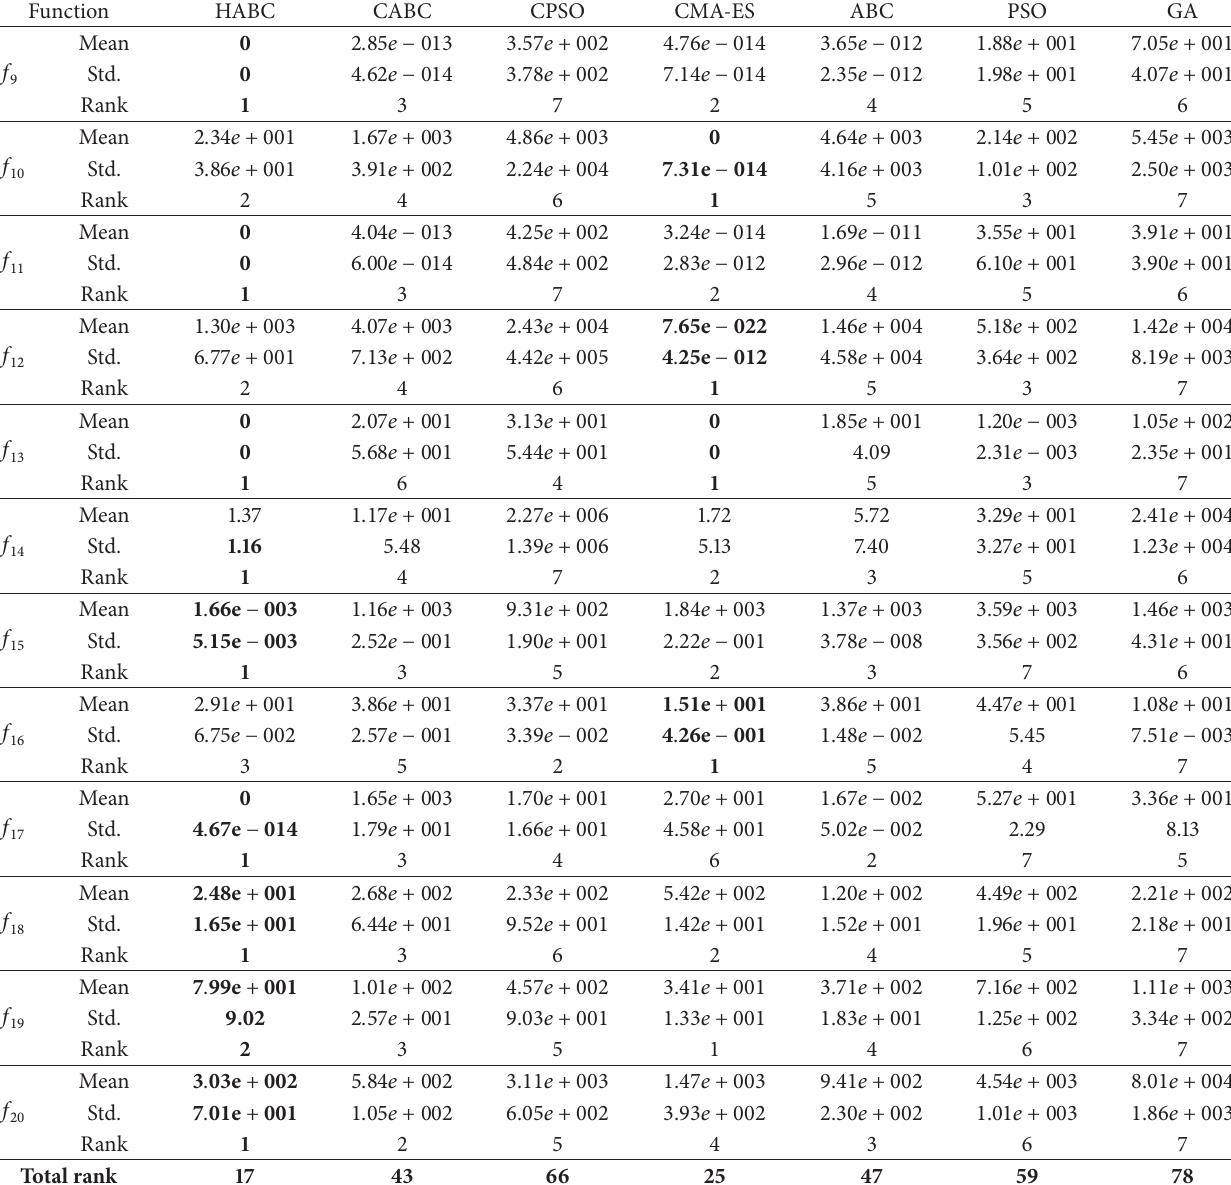
Table 6: Performance of all algorithms on CEC 2005 functions f